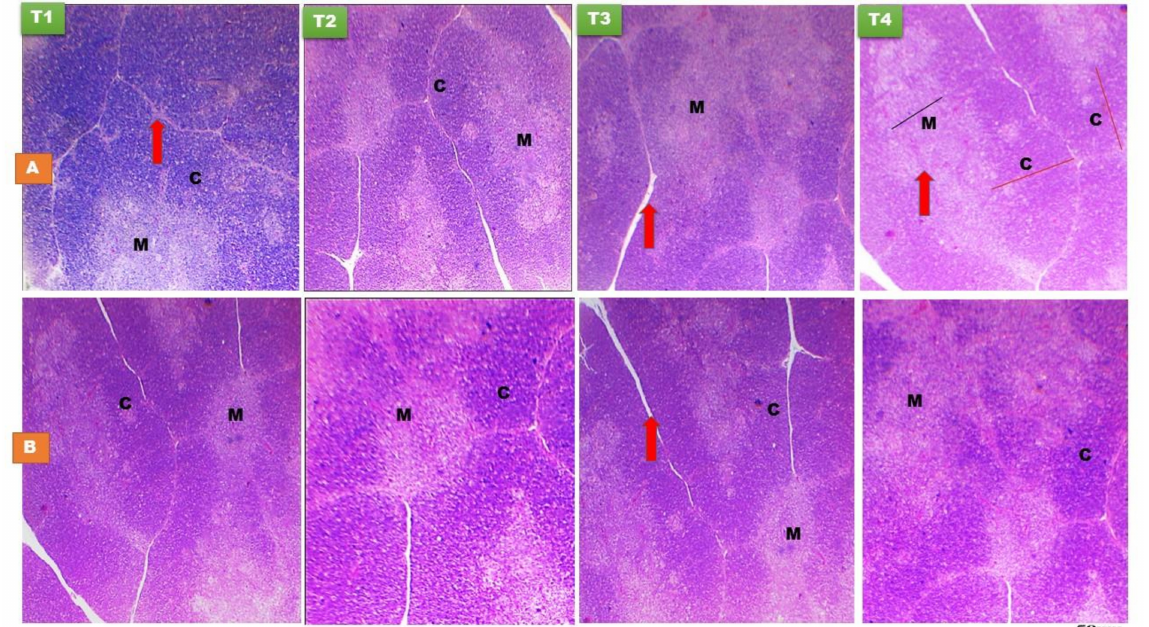
Figure 1. Histological structure of thymus gland at day 14 ( A ) and day 28 ( B ) of age of layer-type chicks exposed to fasting (control, T1) or early feeding on a layer starter diet (T2), a layer starter diet contained 3% molasses (T3), and a broiler starter diet (T4) during the first 72 h post-hatching. M, medulla; C, cortex. Thymus trabeculae (red arrow). Area of cortex with dark staining (red line) and area of medulla with light staining (black line) (H and E × 40 and 100). Table 2. Effect of early nutrition with different diets post-hatching (PH) on the relative weights (% of live body weight) and histomorphology of lymphoid organs and proventriculus ( µ m) of layer-type chicks at day 14 of age. Treatments 1 SEM p -Value Items 2 CON-T1